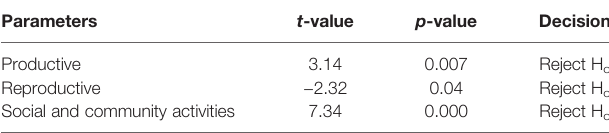
TABLE 2 | Comparison between productive, reproductive, social, and community activities performed by men and women. Parameters